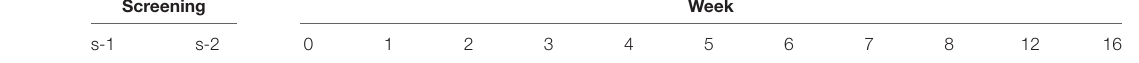
TABLE 2 | Schedule of assessments.